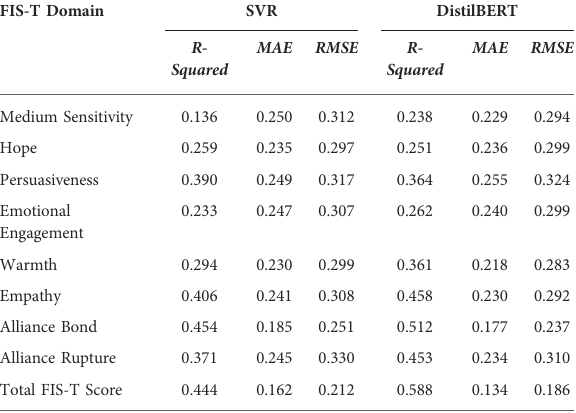
Note: bold indicates superior relative performance versus the competing